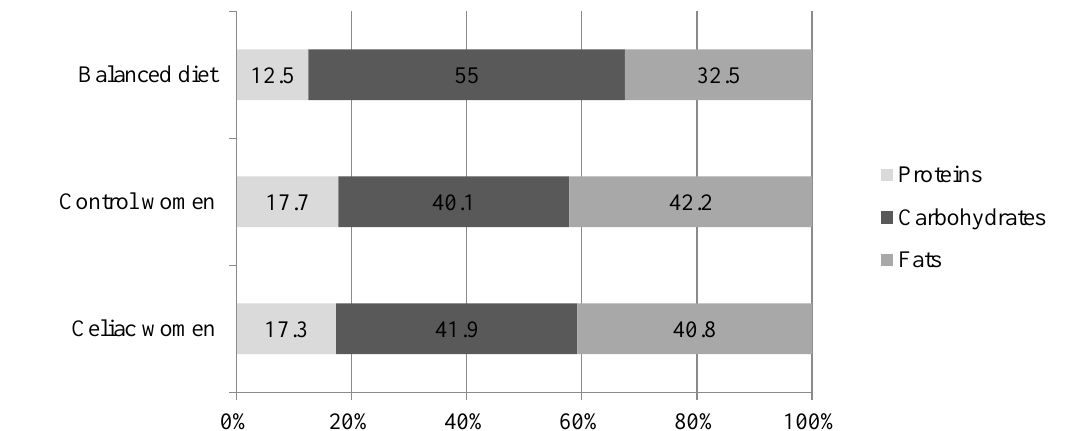
Figure 1. Energy percentage from each macronutrient in celiac ( n = 54) and Spanish women—control women ( n = 1734) (ENIDE study, representative at national level of the adult population) compared to the recommended percentage in a balanced diet proposed by the Federation of Spanish Societies of Nutrition and Dietetics (FESNAD).